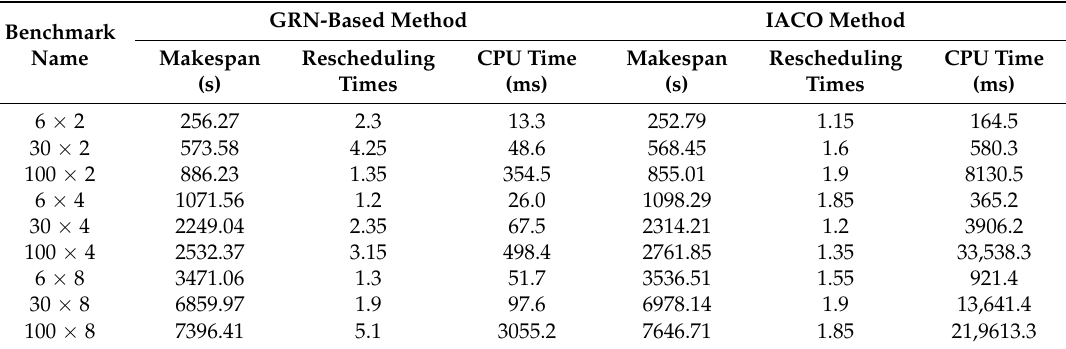
Table 6. Results of the GRN (Genetic Regulatory Network)-based method and IACO (Improved Ant Colony Algorithm)